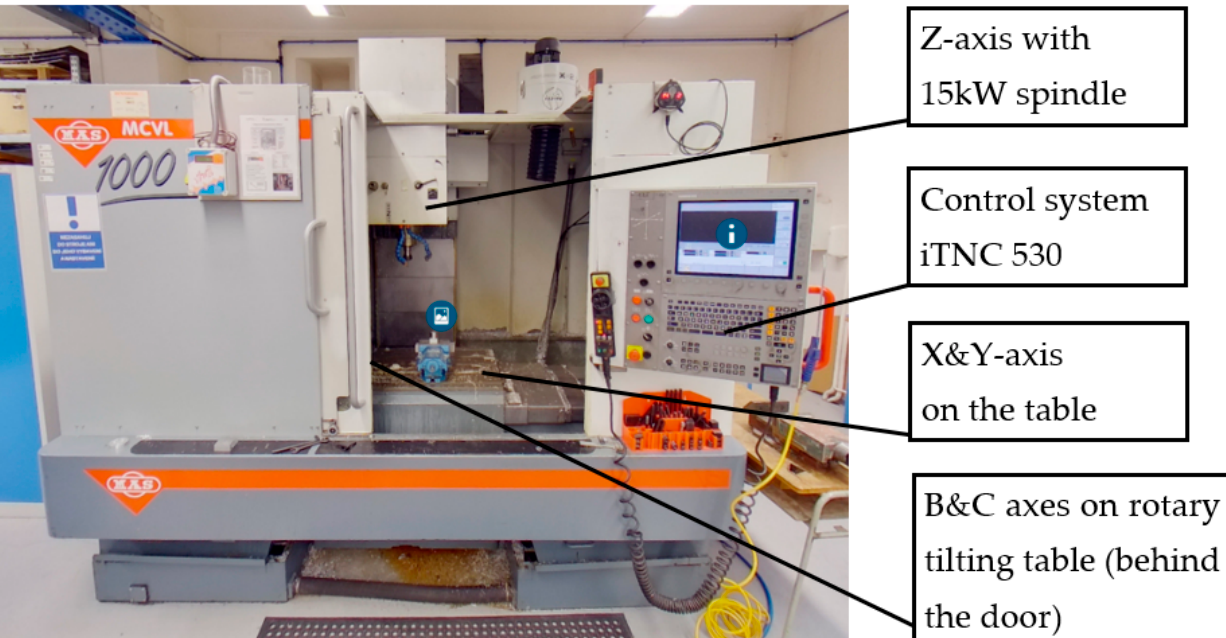
Figure 7. MCVL 1000 five-axis milling machine equipped with Heidenhain iTNC530 control system.